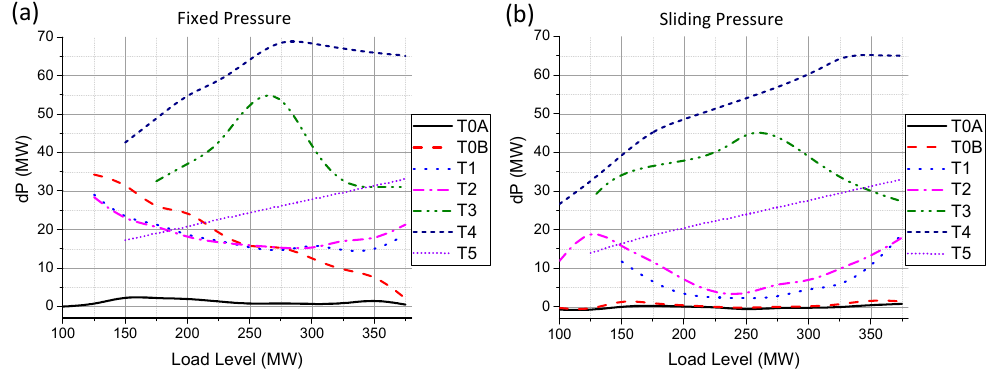
Figure 11. Power penalty on the plant cycle ( dP ) in FP ( a ) and SP ( b ) operating mode.